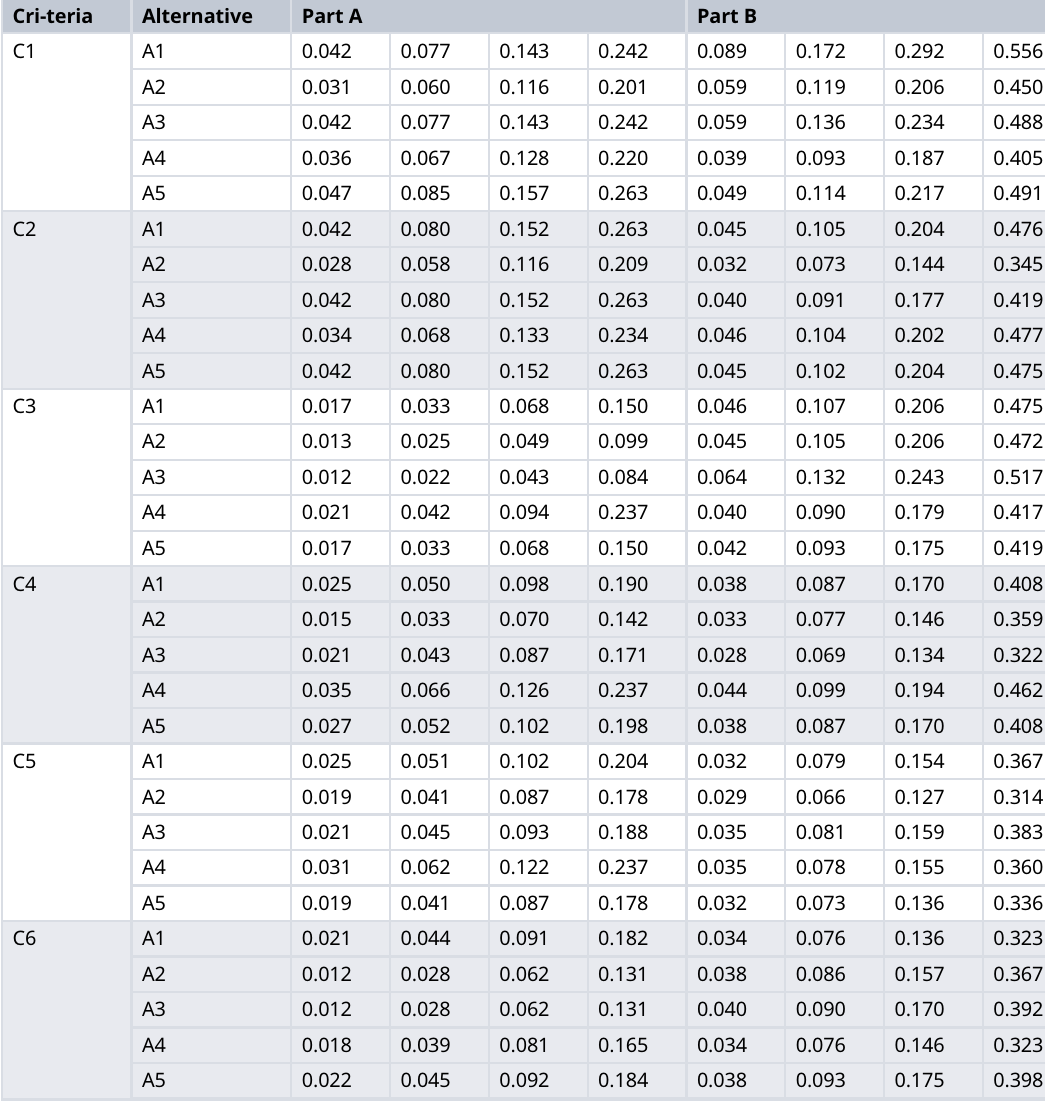
Table 8. Z-number-based weighted normalized decision matrix. Cri-teria